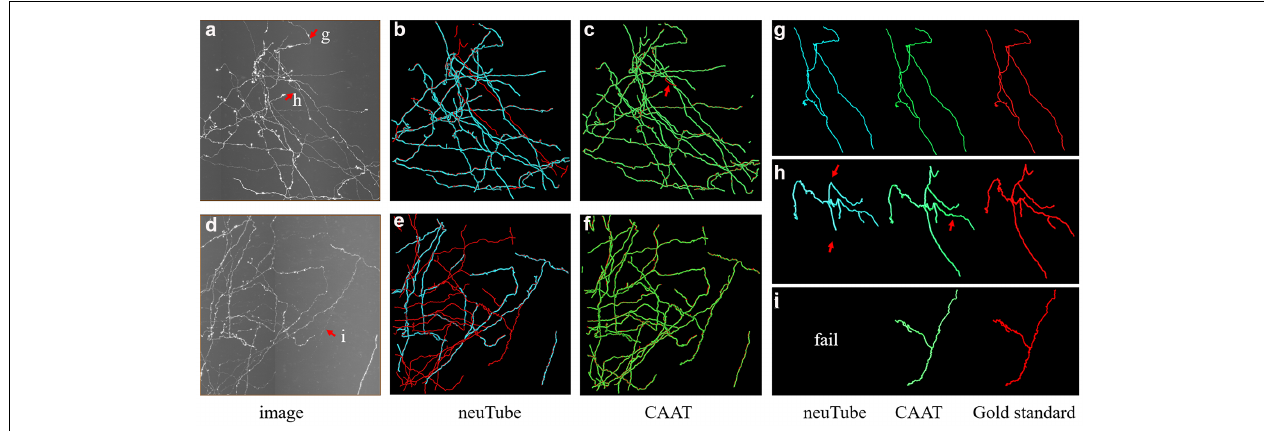
FIGURE 9 | Comparative performances of the proposed method and neuTube algorithms on dense and challenging neuron datasets that contained multiple neurites and various branch structures. Panels (B,C,E,F) show the fusion results of automatic algorithms (blue, green) and gold standard (red). Panels (G–I) are examples of the traced results that are marked in images (A,D) . Inaccurate traced areas were pointed our by arrows.